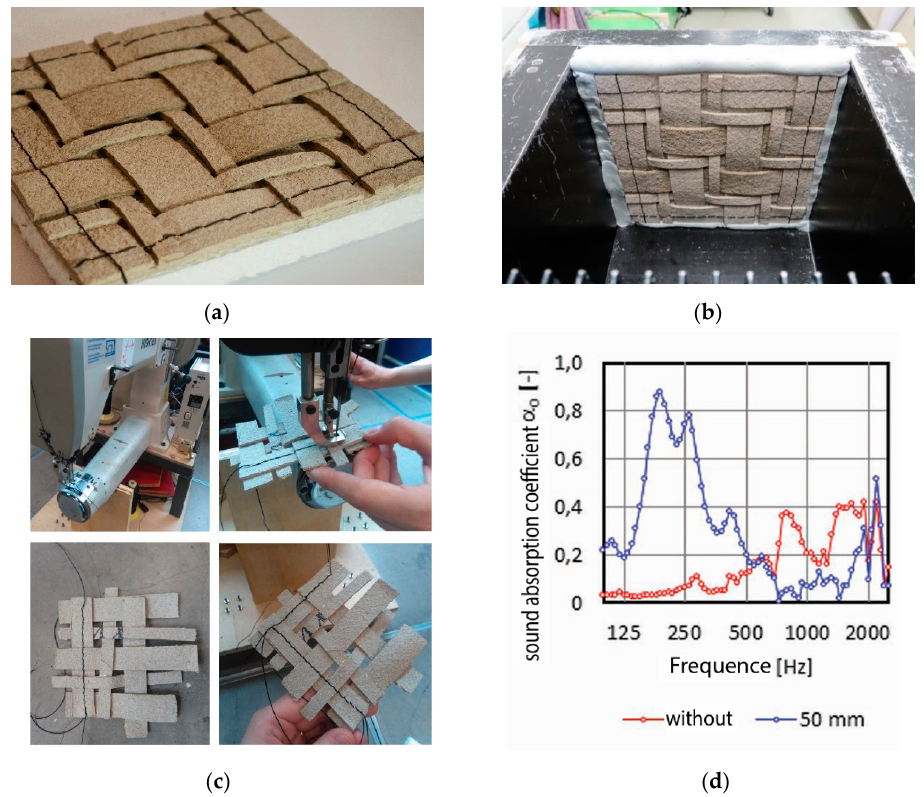
Figure 4. Ignot bio- acoustic sandwich panel ( a ) bio-acoustic sandwich panel before acoustic measurement ( b ) bio-acoustic sandwich panel during the acoustic absorption test with closed edges; ( c ): Knitting/tailor process of the lignocellulosic biocomposite layers before being fixed on the biofoam